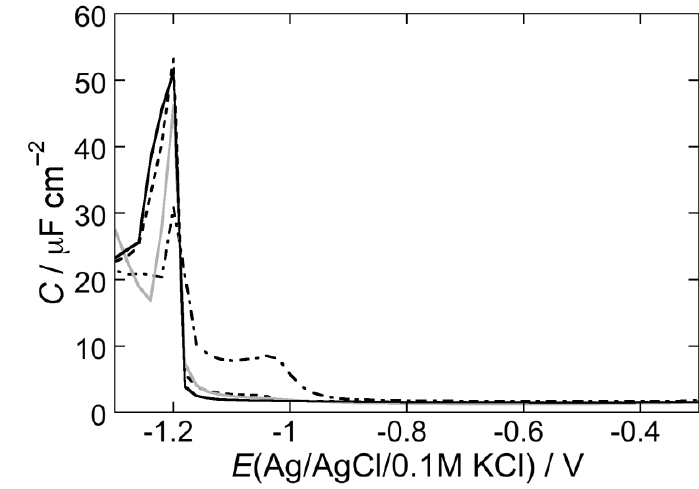
Figure 6. AC voltammogram at a DOPC SAM in a pH 3 aqueous solution of 0.1 M KCl in the absence of the type I’ β -turn peptide structure CSF114 (solid curve), and in the presence of 2 μg/mL CSF114 after five potential scans from −0.2 to −1.5 V (dashed curve) and after a single EIS scan (dash-dotted curve). The gray curve is the AC voltammogram at a DOPC SAM in a pH 7 buffer solution of 0.1 M KCl and 2 μg/mL CSF114 after a single EIS scan. Frequency = 75